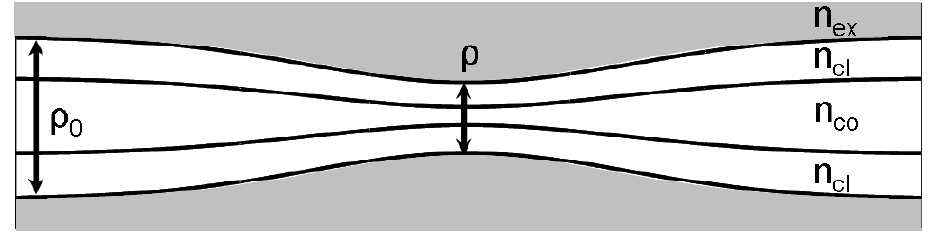
Figure 1. Schematic structure of a cladded fiber